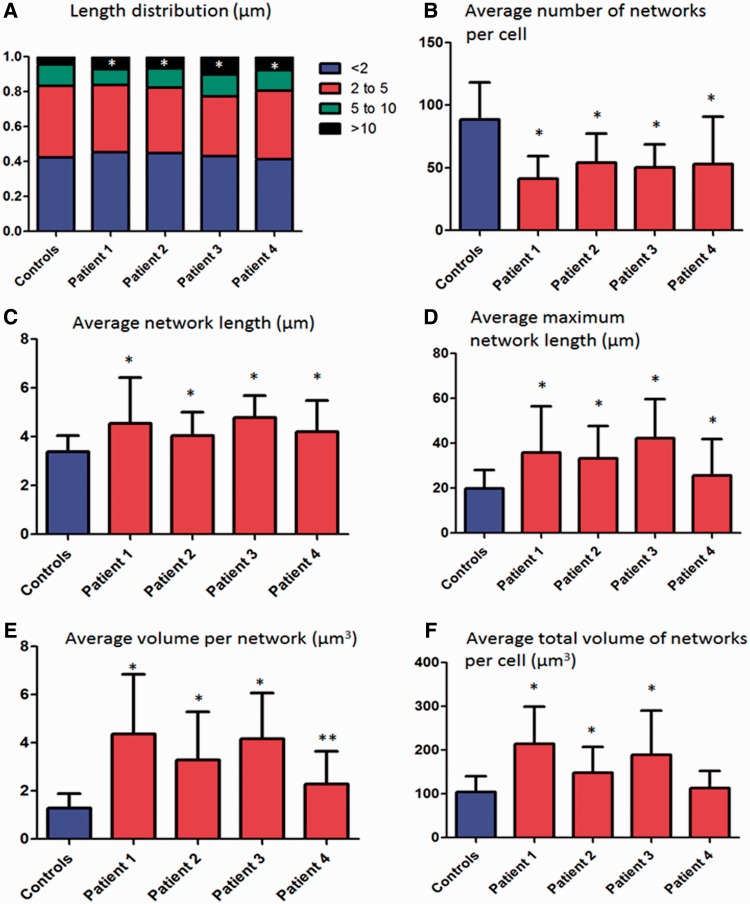
Mitochondrial network analysis. Mitochondrial network analysis was undertaken in fibroblasts (Patients 1–4) grown concurrently with identical medium and conditions. Error bars are SD. Controls are the aggregate results of four separate cell lines (50 cells each for total 200 cells). (A) The distribution of the network lengths is demonstrated; very long networks (>10 µm) were significantly more abundant in patients with compound heterozygous SPG7 mutations than controls. (B) The average number of total networks per cell was significantly lower in SPG7 patients. (C) The average length per mitochondrial network was increased in SPG7 patients, as was the average longest network per cell (D). The volume of individual mitochondrial networks was higher than controls per cell line (E) and the total volume of the mitochondrial network per cell was elevated (in all cell lines except Patient 4 which was not significant) (F). We suggest that these hyperfused mitochondrial networks may be a compensatory mechanism, and that the elevated total mitochondrial volume corresponds to the elevated mitochondrial mass observed in COX-deficient fibres in these patients. *P < 0.0001 and **P = 0.004.